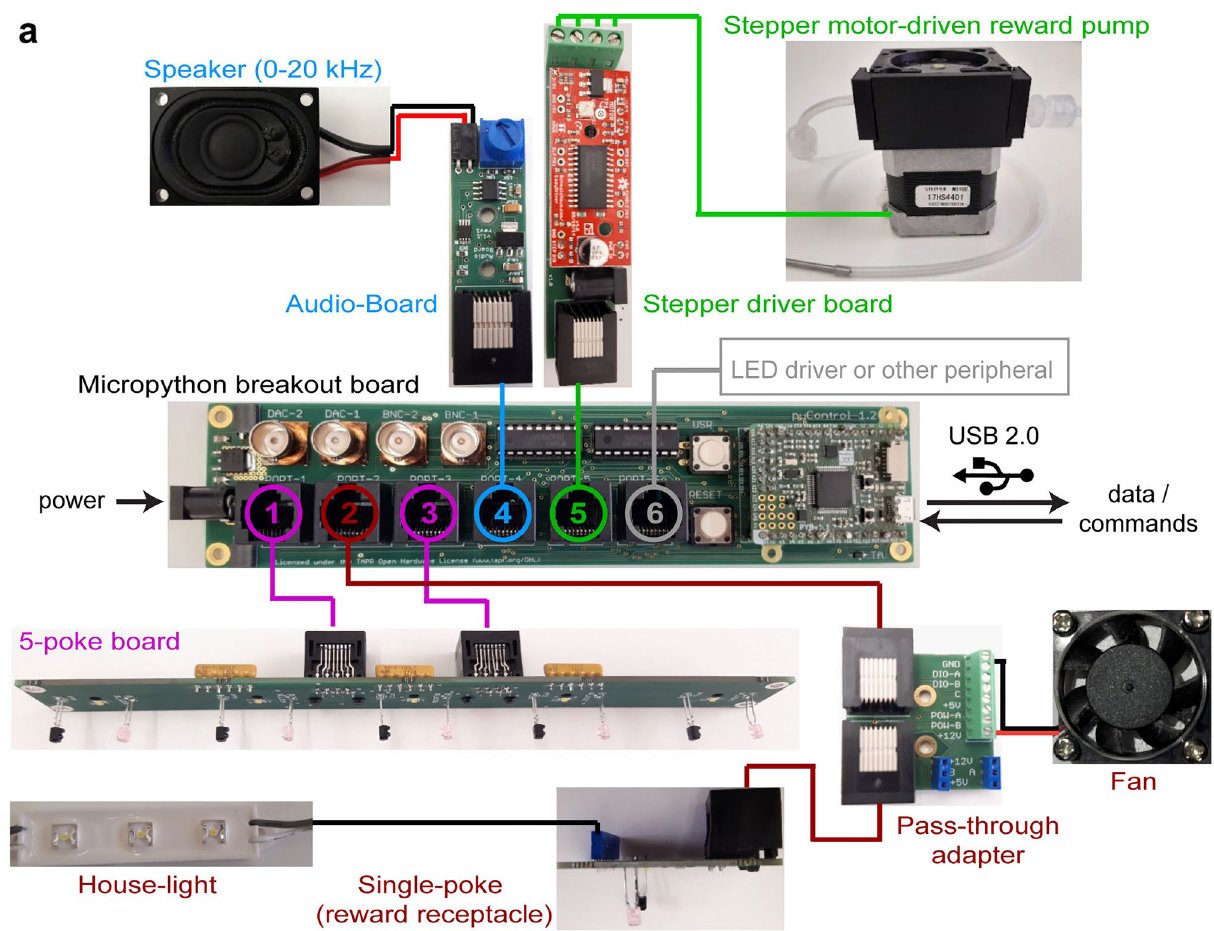
Figure 1. Connections between PCBs and peripherals. ( a ) Cabling scheme for the 5-choice operant box between PCBs and the peripherals they control showing named peripherals that plug into the indicated RJ45 (ethernet) ports (coloured numbers) of the pyControl breakout board. This includes the 5-poke board (RJ port 1 and 3), the single-poke receptacle board (port 2), the audio-board to deliver tones through a speaker (port 4), the stepper-motor control board to control a custom-made peristaltic pump for reward delivery (port 5), and an LED-driver for optogenetic stimulation through implanted LEDs (port 6, not shown); coloured lines represent RJ45 cables. The four BNC ports allow bidirectional communication with external devices through TTL